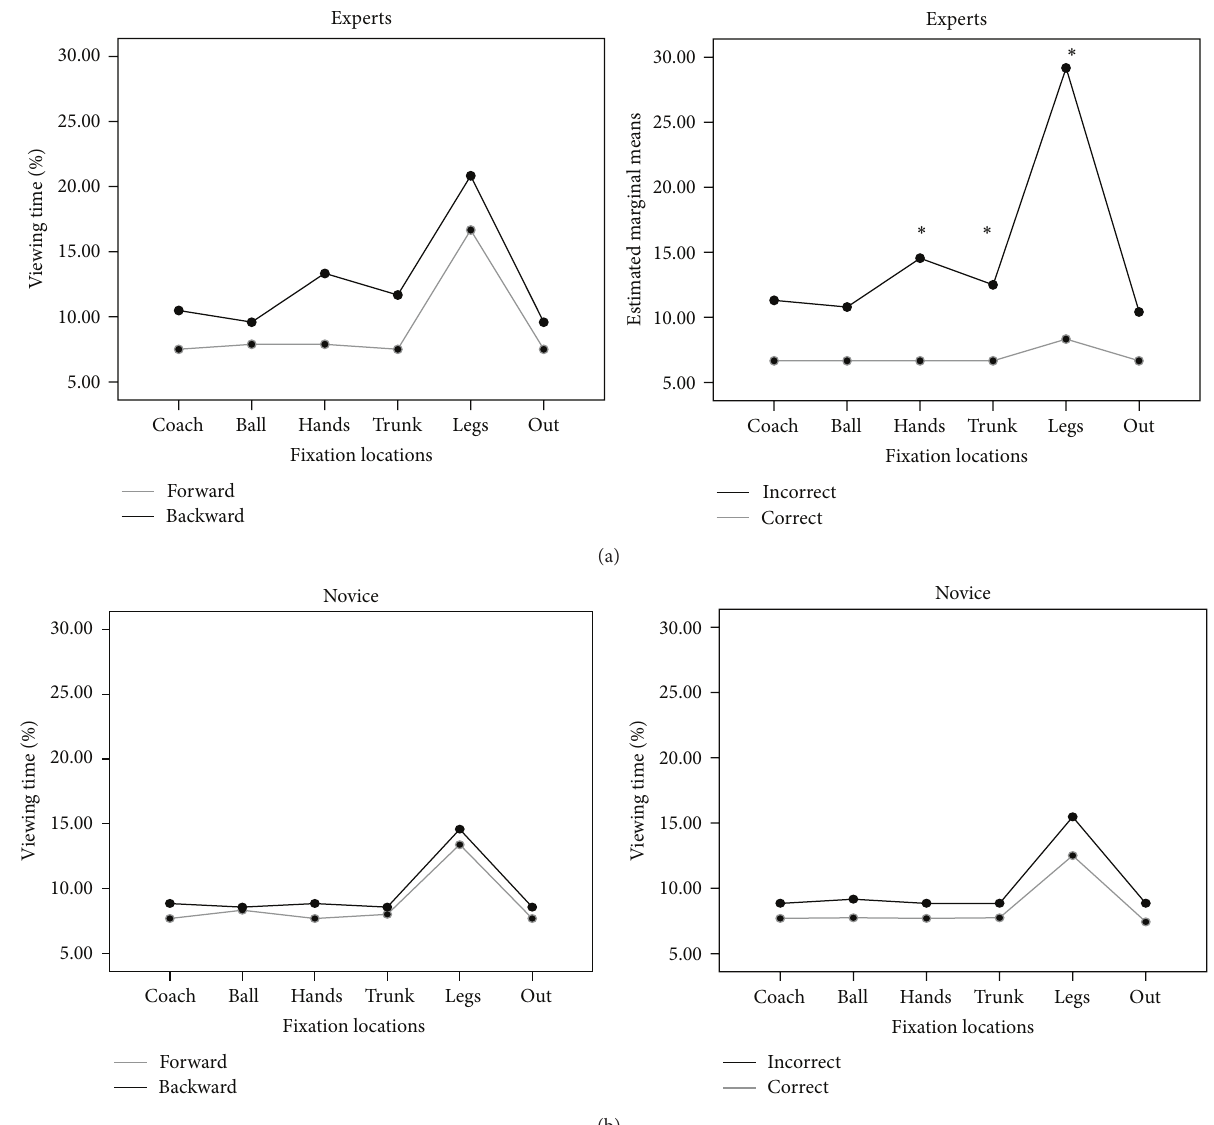
Figure 5: Mean percentage of time spent by experts (a) and novices (b) viewing each location for the backward (black lines) and forward (gray lines) settings on the left chart and incorrect (black lines) and correct (gray lines) responses to the right chart. Asterisks show significant differences ( 𝑃 < .001